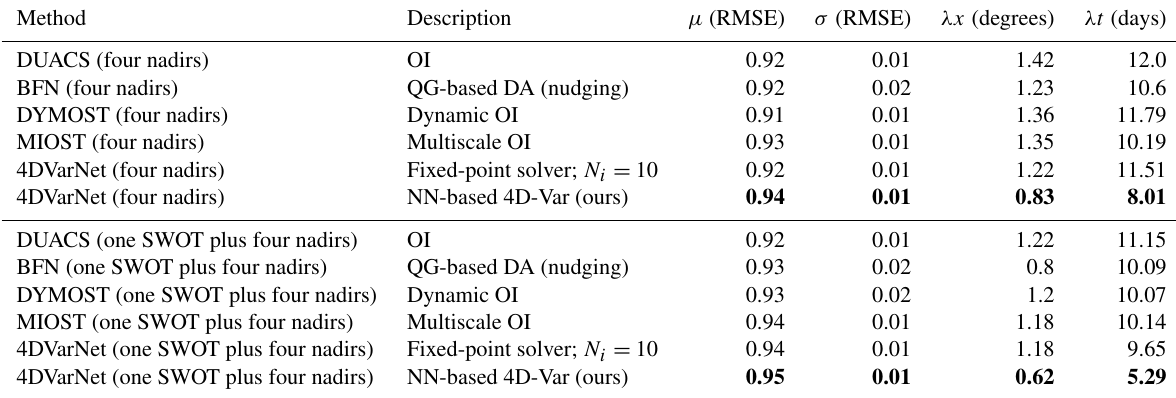
Table 2. 4DVarNet-SSH performance on the GULFSTREAM domain compared to DUACS OI (traditional covariance-based optimal inter- polation), BFN (back-and-forth nudging of a QG model), MIOST (multiscale OI), DYMOST (dynamic OI accounting for nonlinear temporal propagation of the SSH fields), fixed-point versions with 10, and a single iteration of the 4DVarNet solver, over the period from 22 October to 2 December 2012 (42d). Bold formatting stands for the best metrics.